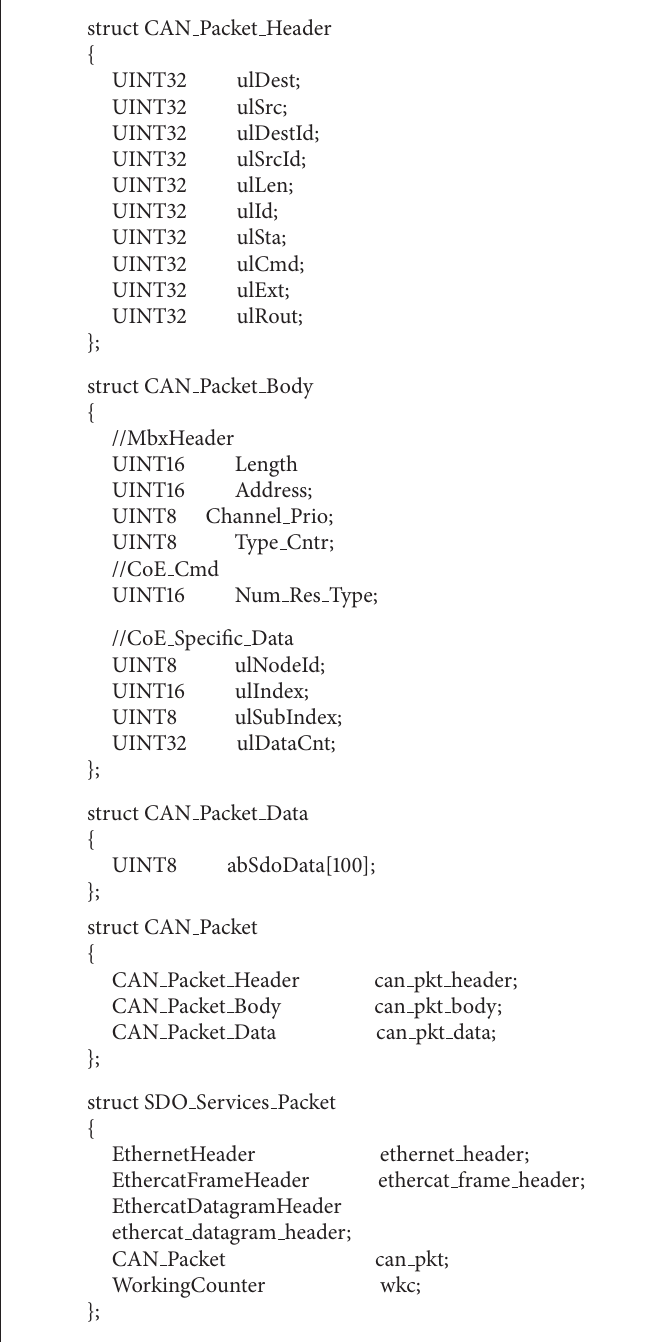
Algorithm 2: CoE frame structure (header file: ecat packet.h).